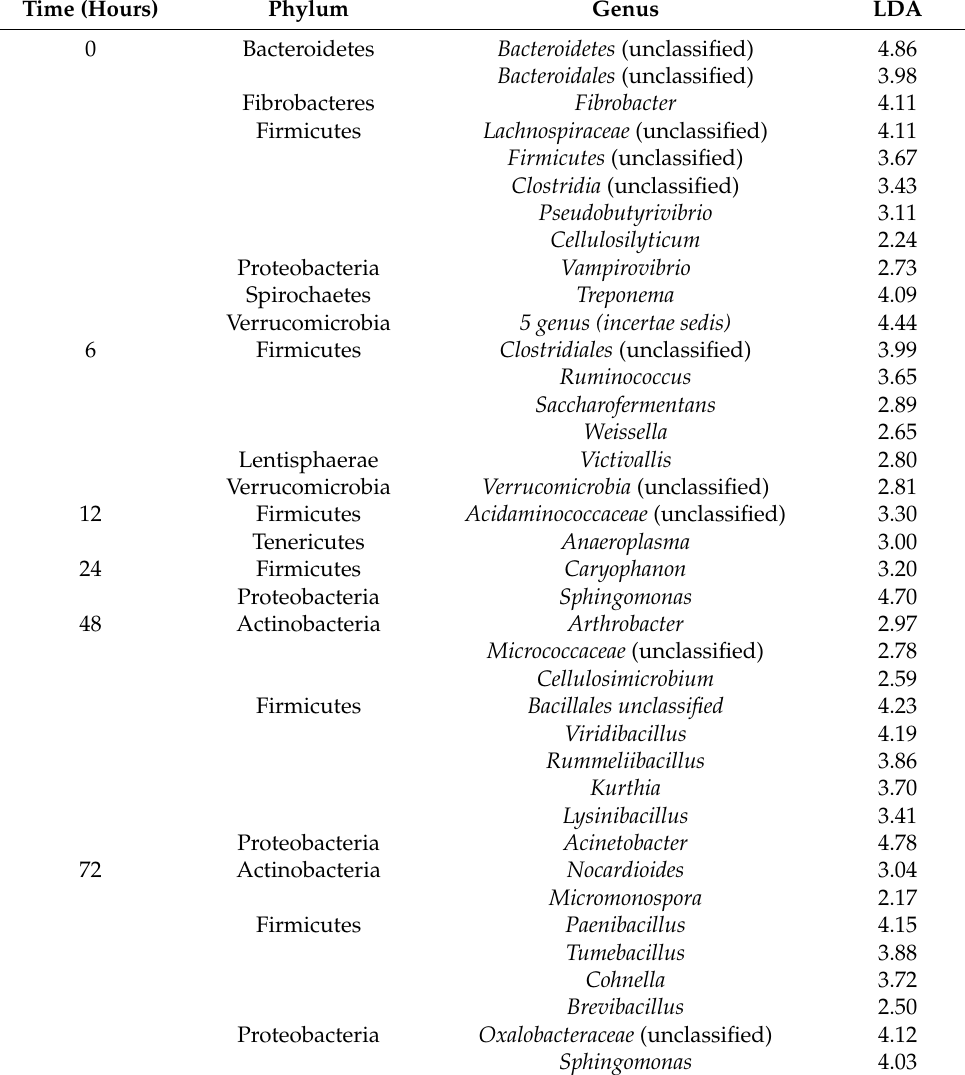
Table 2. Differentially enriched taxa with linear discriminant analysis (LDA score ≥ 2 identified in the horse’s fecal samples storage at ambient temperature up to 96